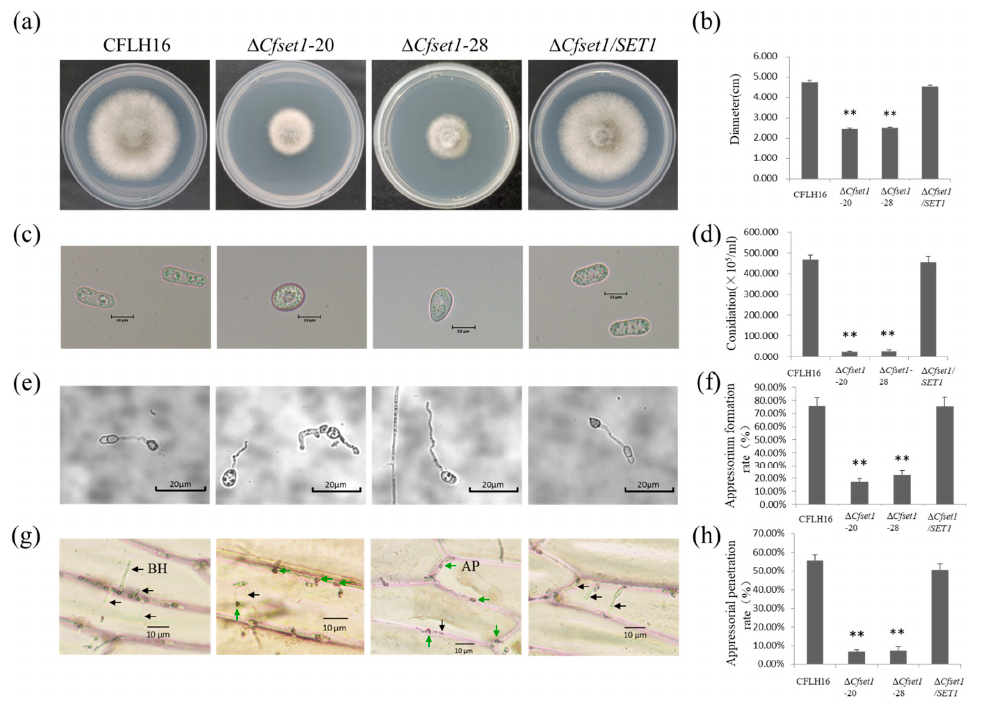
Figure 1. Vegetative and reproductive growth as well as appressorium formation of C. fructicola . ( a ) Growth rate of mutants Δ Cfset1 -20 and Δ Cfset1 -28 were significantly reduced . ( b ) Statistical analysis of the colony diameter. ( c ) Conidial morphology of Δ Cfset1 mutants were larger and more spherical than CFLH16 and Δ Cfset1 / SET1 . ( d ) Conidiation of mutant strains Δ Cfset1 -20 and Δ Cfset1 -28 were significantly reduced . ( e ) Appressorium formation of mutant strains Δ Cfset1 -20 and Δ Cfset1 -28 were significantly reduced. ( f ) Statistical analysis of the rate of appressorium formation on hydrophobic slides. ( g ) The biotrophic hyphae of mutant strains Δ Cfset1 -20 and Δ Cfset1 -28 were significantly reduced. Green arrows: appressorium (AP). Black arrows: biotrophic hyphae (BH). ( h ) Statistical analysis of appressorial penetration rate. Double asterisks indicate that each mutant has significant differences with wild-type and complemented strains ( p < 0.01).